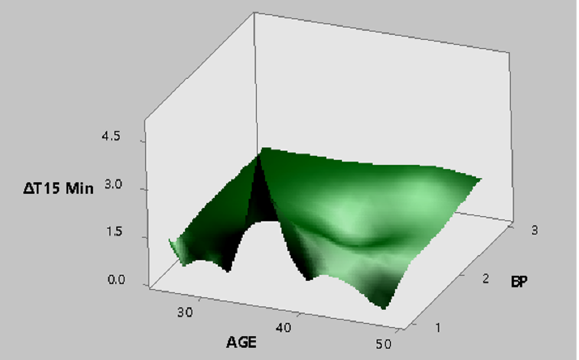
Figure 11. Response surface produced for the tolex area from the palm of the hand for the minimum temperature difference in time 15 ′ and the factors age and BP.